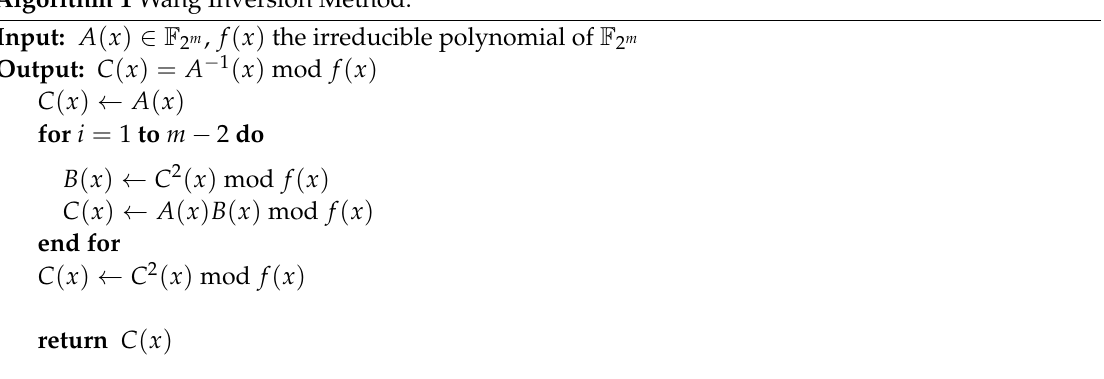
Algorithm 1 Wang Inversion